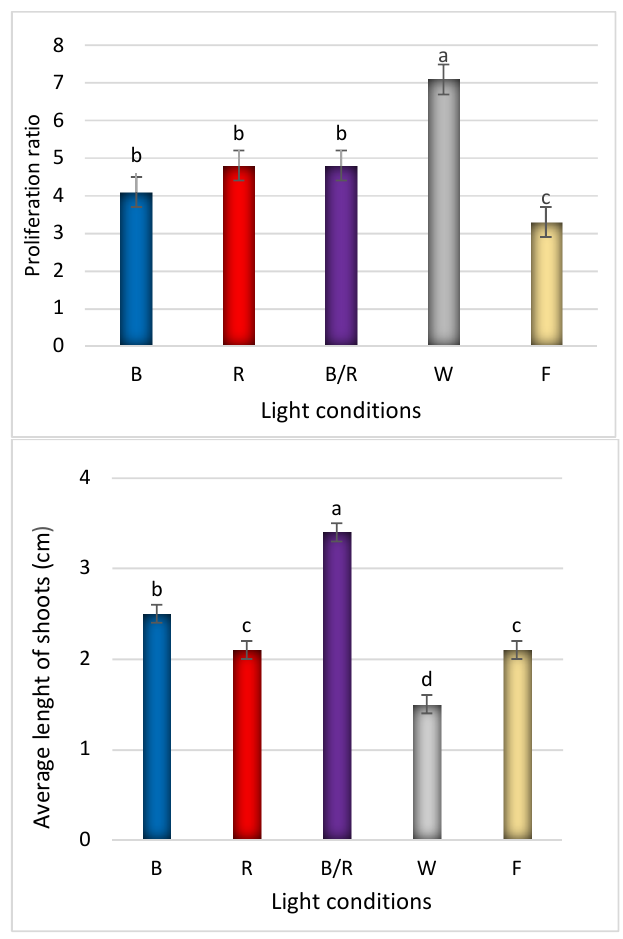
Figure 1. The effect of light conditions: ( B ) blue, ( R ) red, ( B/R ) blue/red, ( W ) white, ( F ) fluorescent on proliferation and length of D. forrestii shoots. The values represented means ± SE of three independent experimental replicates. The means marked with various letters for the same parameter were different at p < 0.05 according to one way ANOVA test followed by the post-hoc Tukey’s test.